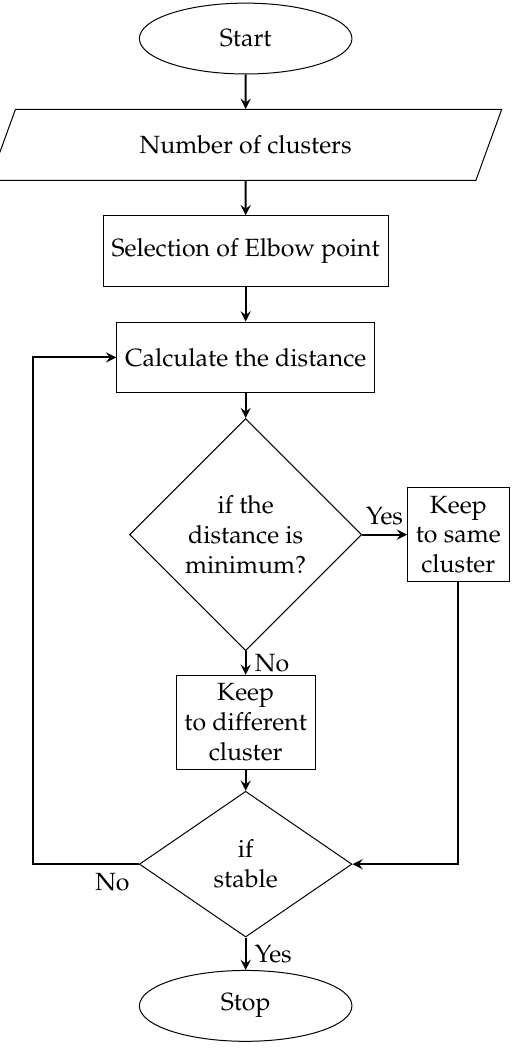
Figure 2. Data selection